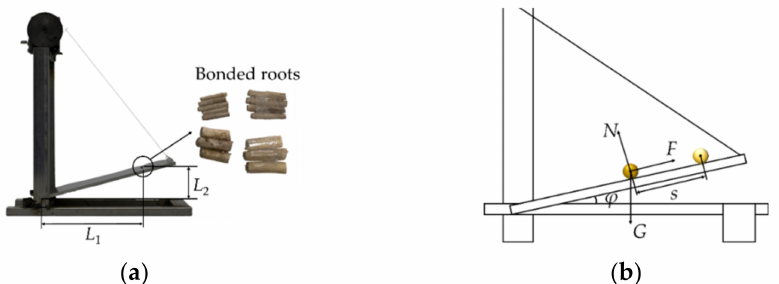
Figure 7. Measurement of friction coefficient determination. ( a ) Static friction coefficient µ s ; and ( b ) Rolling friction coefficient µ r